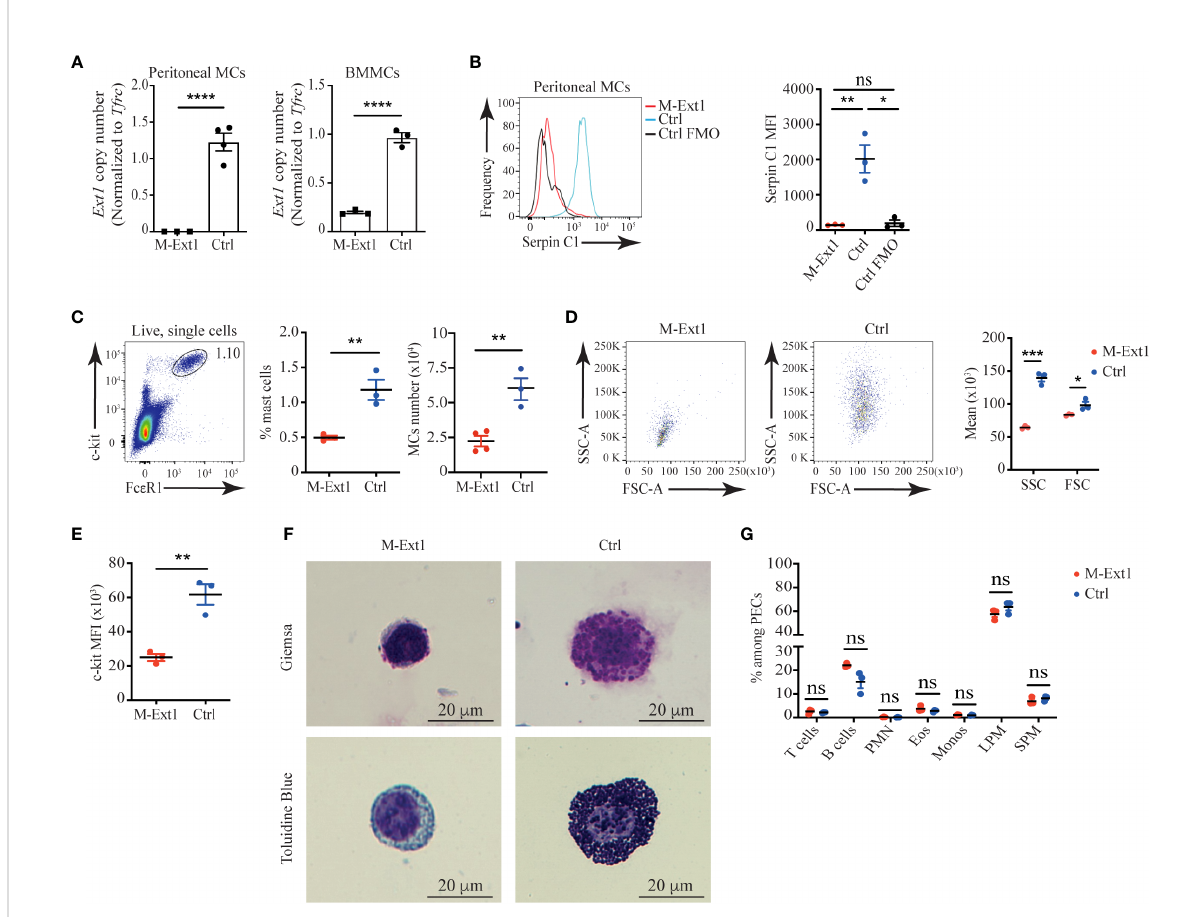
FIGURE 2 Peritoneal MCs in 6-weeks old Heparin de fi cient mice are reduced in numbers and lack granules. (A) Ext1 gene copy number analyzed by qPCR from sorted peritoneal MCs and bone marrow-derived mast cells (BMMCs) from M-Ext1 and control mice. (B) Representative histograms and statistics of mean fl uorescent intensity (MFI) of Serpin C1 binding to fi xed and permeabilized peritoneal MCs. Staining of control cells with the omission of the biotinylated SerpinC1 was used as fl uorescence minus one (FOM) control. (C) Representative gating strategy, percentages and numbers of peritoneal MCs in M-Ext1, and control mice. (D) Representative fl ow cytometry plots and geometric means of forward scatter (FSC) representing size and side scatter (SSC) representing granularity of peritoneal MCs in M-Ext1 and control mice. (E) Mean fl uorescent intensity of c-kit expression in peritoneal MCs in M-Ext1 and control mice. (F) Representative Giemsa and Toluidine Blue staining of c-kit-magnetic beads enriched peritoneal cavity MCs from M-Ext1 and control mice. (G) Percentages of different cell populations isolated from the peritoneal cavity determined by fl ow cytometry; PMN – polymorphonuclear granulocytes, Eos – eosinophils, Monos – monocytes, LPM – large peritoneal macrophages, SPM – small peritoneal macrophages. Results are represented as mean ± SEM. Each symbol in the graphs is an individual mouse. Flow cytometry plots in (B – E , G) are representative of 3 individual experiments. Images in (F) are representative of 3 individual mice of each genotype. Statistical signi fi cance was determined by unpaired Student ’ s t-test. Values of p<0.05 were considered statistically signi fi cant, *p < 0.05, **p < 0.01, ***p < 0.001, ****p < 0.0001, ns, not signi fi